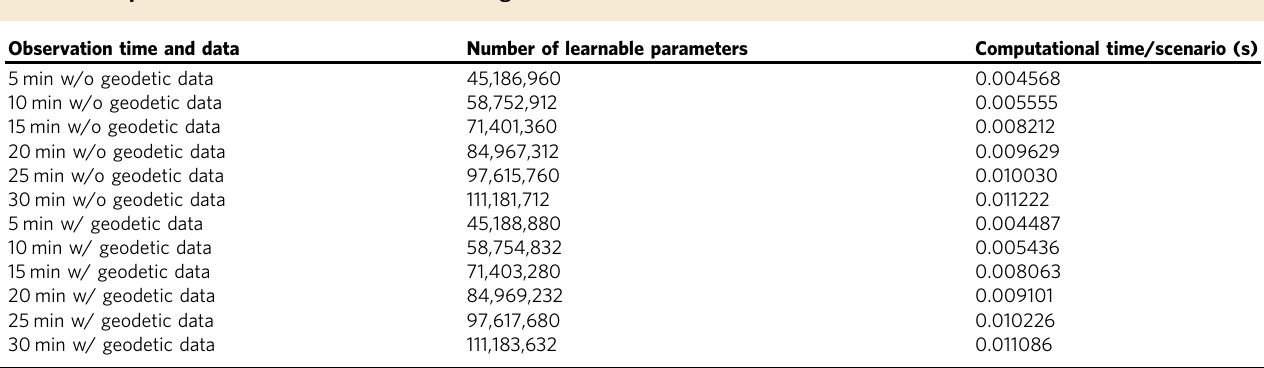
Fig. 5 Results of sensitivity analysis for convolutional neural networks (CNN) with different observation times. a CNN trained only with offshore tsunami observation data. b CNN trained with both offshore tsunami and onshore geodetic observation data. The observation points with high sensitivity indicate that the forecasting result changes considerably when the inputs from these observation points are Table 1 Computational time for tsunami forecasting.